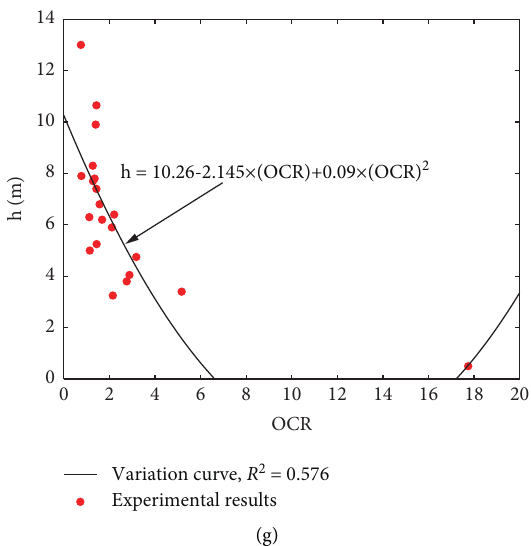
Figure 5: Variation curve of overconsolidation ratio with the depth of Guangzhou silt layer. (a) Project 1, (b) project 2, (c) project 3, (d) project 4, (e) project 5, (f) project 6, and (g) project 7.